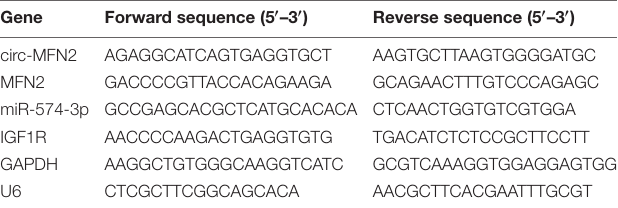
TABLE 2 | The primer sequences used for qRT-PCR. Gene Forward sequence (5 (cid:48) –3 (cid:48) ) Reverse sequence (5 (cid:48) –3 (cid:48)